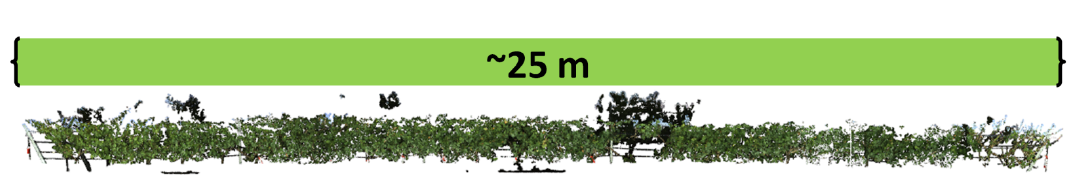
Figure 12. The point cloud of the whole 25 m-long VSP trellis row.